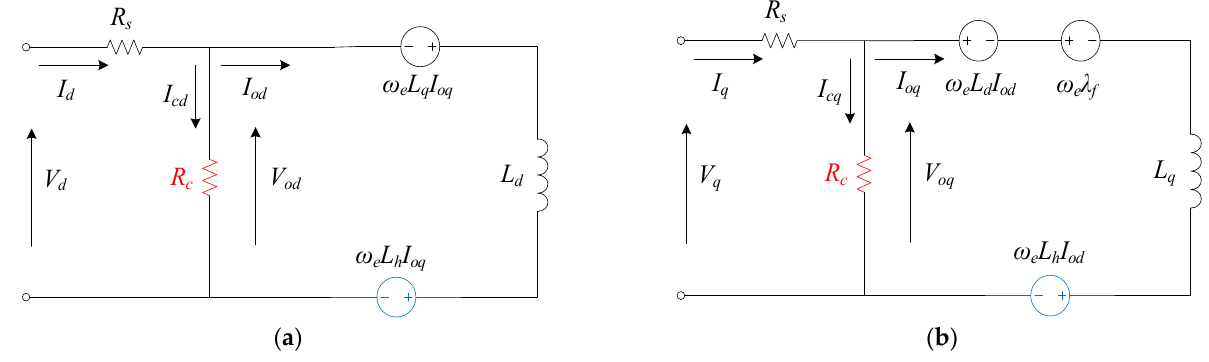
Figure 13. ECM of PMSMs with predictable core loss: ( a ) d -axis; ( b ) q -axis [28].